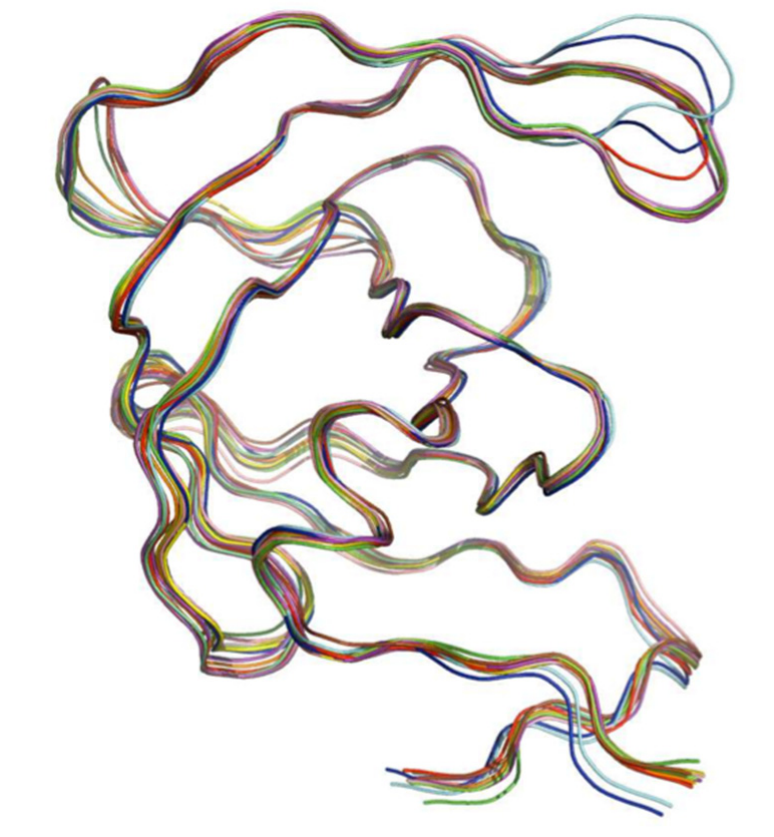
Figure 7. Superposition of mean PR monomer structures for the space groups: P2 (orange), C2 (red), P2 (lime green), P4 P6 22 (pink) and I2 1 the distribution of space groups in the final data